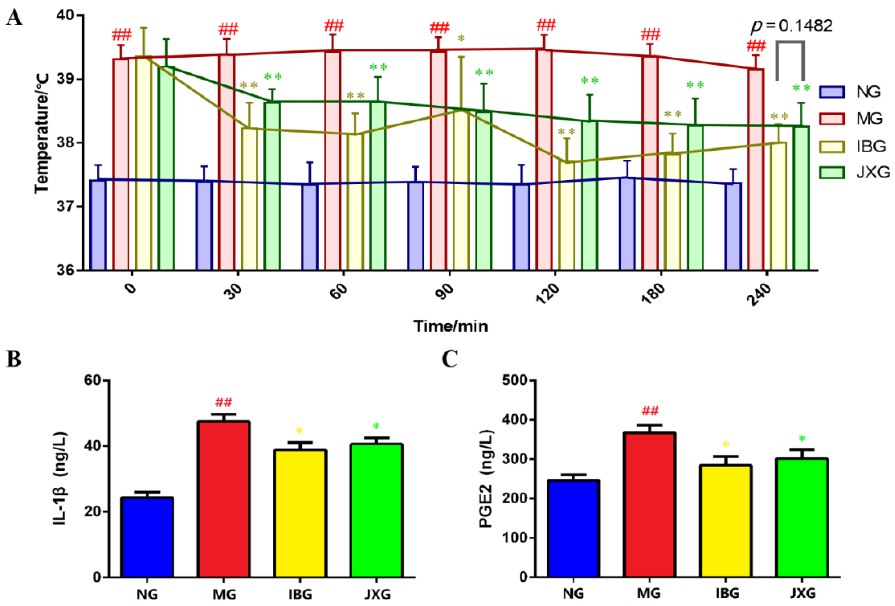
Figure 1. Antipyretic and anti-inflammation effects of IB and JXOL. A: The rectal temperatures were measured at 0, 30, 60, 90, 120, 180, and 240 min after drug administration. B: Effects of JXOL on the production of IL- 1β and PGE2. (# p < 0.05, ## p < 0.01, vs. NG; * p < 0.05, ** p < 0.01, vs. MG).